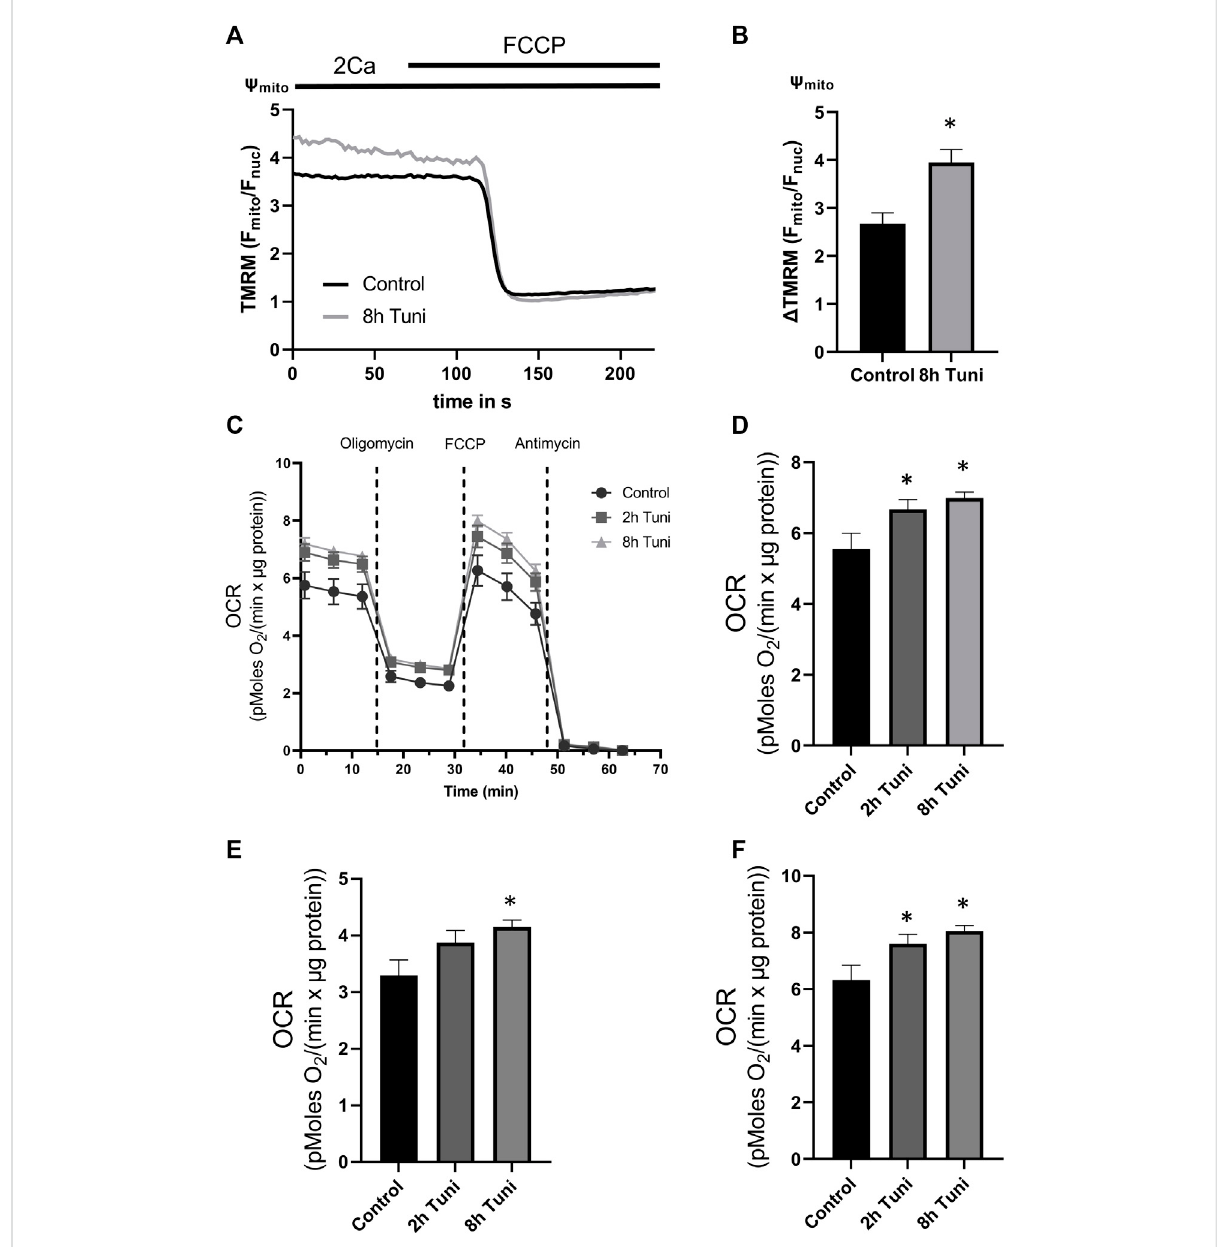
Mitochondrial membrane potential and OCR are increased in cells treated with tunicamycin. (A) HeLa cells labeled with the mitochondrial membrane potential dependent dye TMRM were used. Representative Ψ mito (TMRM F mito /F nuc ) traces upon FCCP induced loss of Ψ mito of control HeLa cells or HeLa cells treated with 0.6 µM tunicamycin for 2 h or 8 h. (B) Bar graphs (MEAN ± SEM) show mitochondrial membrane potential normalized to fully disrupted mitochondrial membrane potential in response to FCCP of control HeLa cells ( n = 3/6/47) or HeLa cells treated withtunicamycinfor8 h( n =3/6/50). (C) OCRchangesmeasuredbySeahorse ® incontrolHeLacellsorHeLacellstreatedwithtunicamycinfor2 hor 8 h. (D) Bar graphs (MEAN ± SEM) show mitochondrial basal respiration of control HeLa cells or HeLa cells treated with tunicamycin for 8 h. (E) Bar graphs (MEAN ± SEM) show ATP-linked respiration of control HeLa cells or HeLa cells treated with tunicamycin for 8 h. (F) Bar graphs (MEAN ± SEM) show maximal respiratory capacity of control HeLa cells ( n = 3/26) or HeLa cells treated with tunicamycin for 2 h ( n = 3/21) or 8 h ( n = 3/24). * p < 0.05 vs. respective control conditions carried out with one-way ANOVA with Tukey corrected posthoc